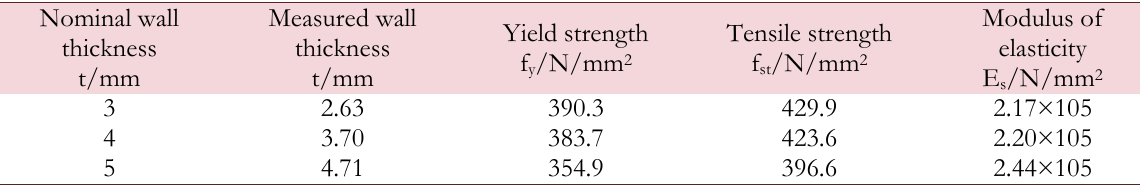
Table 3: Mechanical properties of steel